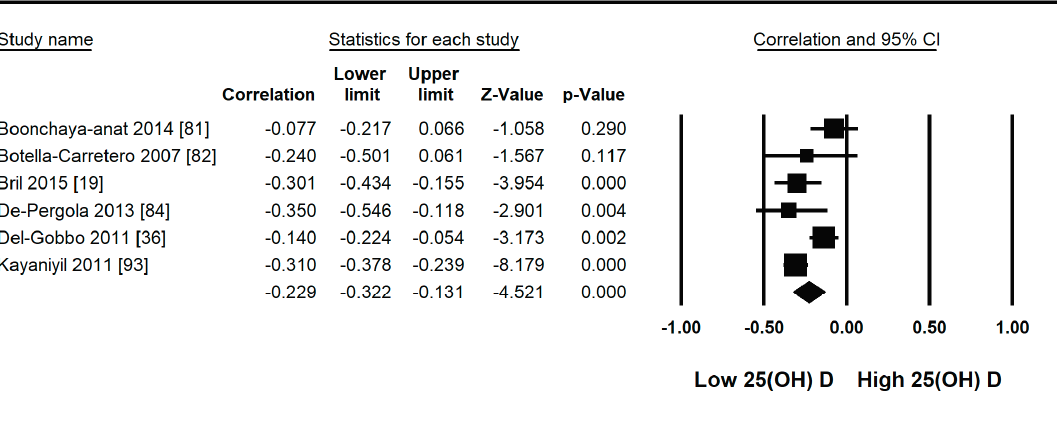
Figure 9. Forest plot for the highest BMI quartile (>30) of non-diabetic subject studies showing the correlation between the status of vitamin D and fasting plasma insulin. The random effects model was used for the determination of correlation and 95% CI [19,36,81,82,84,93].